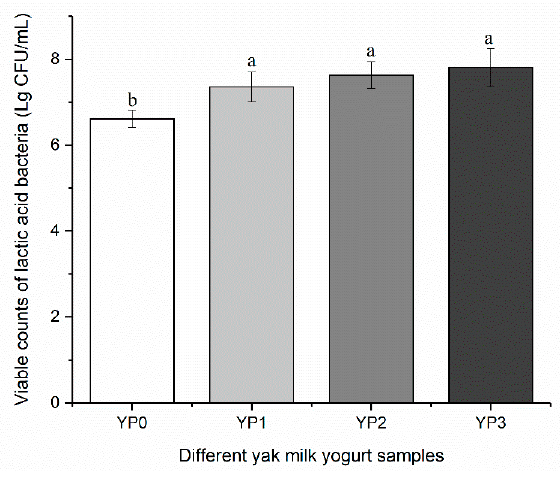
Figure 5. Effect of the addition of PEWH on the viable counts of lactic acid bacteria of yak milk yogurt. Different letters indicate significantly different ( p < 0.05).